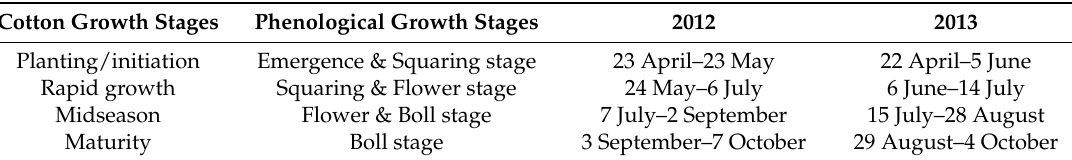
Table 2. Cotton growth stages of 2012 and 2013.